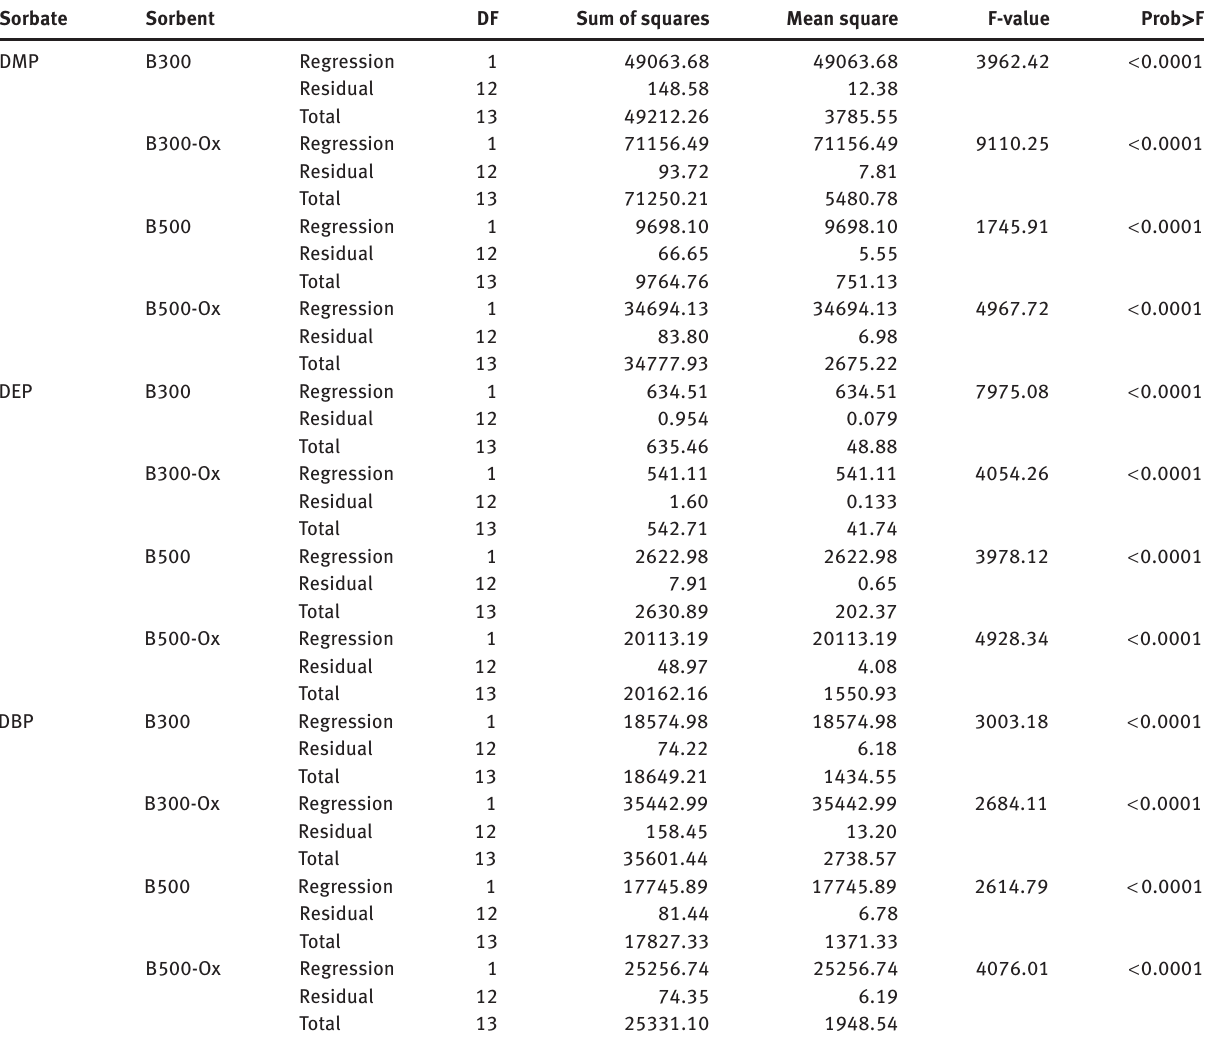
Table 4: Analysis of variance (ANOVA) for adsorption of phthalic acid esters (PAEs). Sorbate